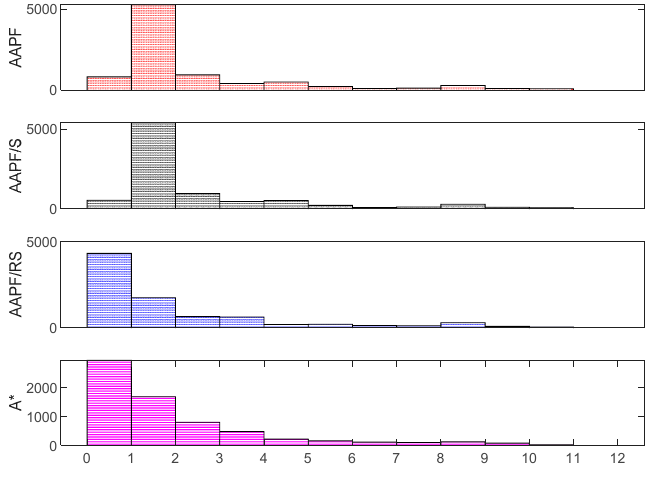
Figure 12. Simulation results on distances to obstacles.